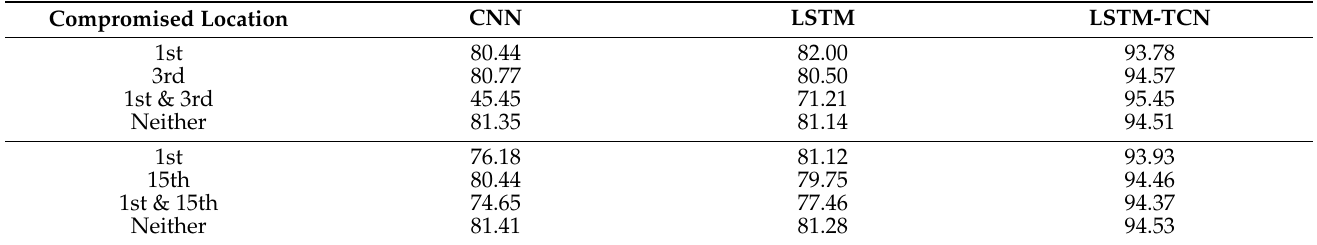
Table 3. Location-based Results on the first, third, and fifteenth measurements under L 2 -norm =